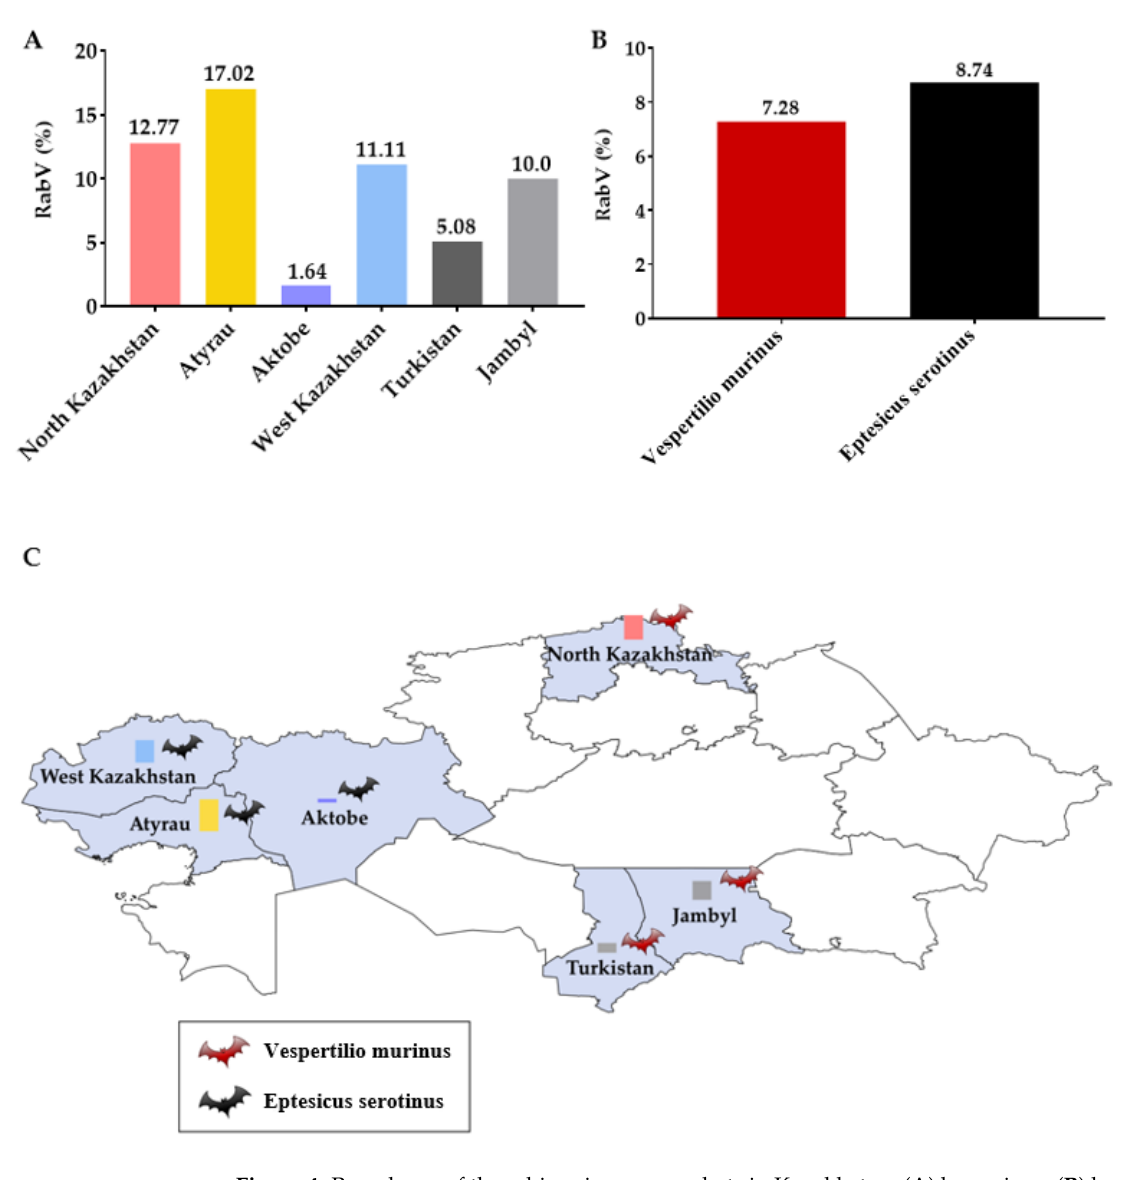
Figure 4. Prevalence of the rabies virus among bats in Kazakhstan. ( A ) by regions; ( B ) by species of bats; ( C ) distribution map. The RNAs of SARS-CoV-2, MERS, TBE, CCHF, WNF, influenza A viruses were not detected in the bat samples.